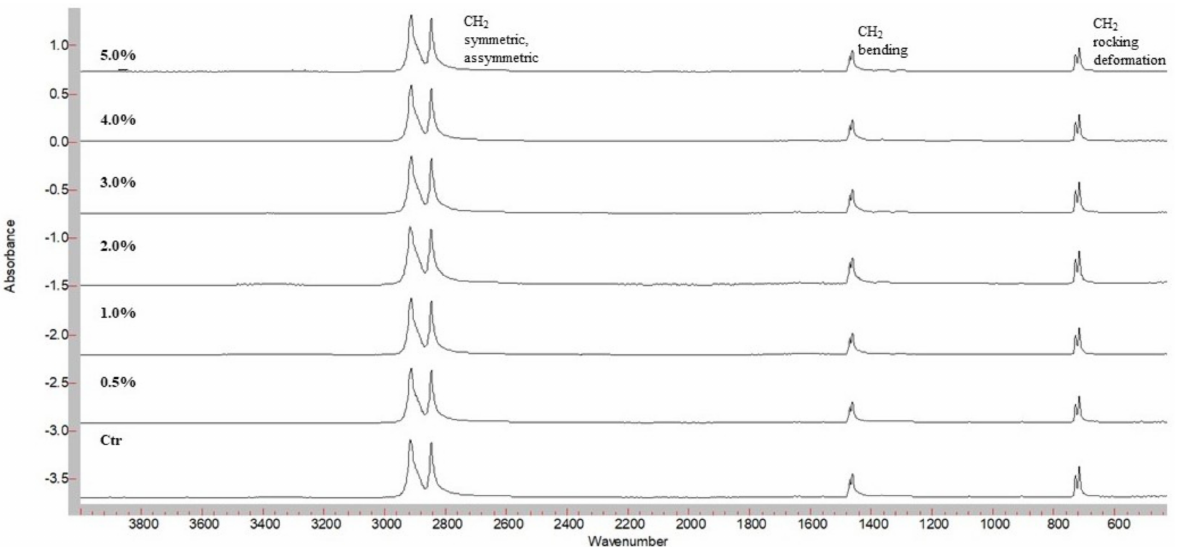
Figure 5. FTIR spectra for samples containing the biocide in a concentration from 0.5% to 5% and gfor the control sample - without biocide (Ctr).